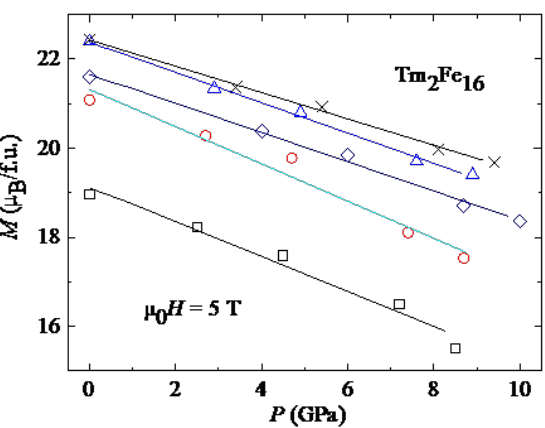
Fig. 4. Pressure dependences of the magnetization of Tm 2 Fe 16 measured in a field of 5 T at T = 5 K (□), 50 K (o), 100 K (Δ), 150 K (×), 200 K (◊). The lines are the linear fits of the